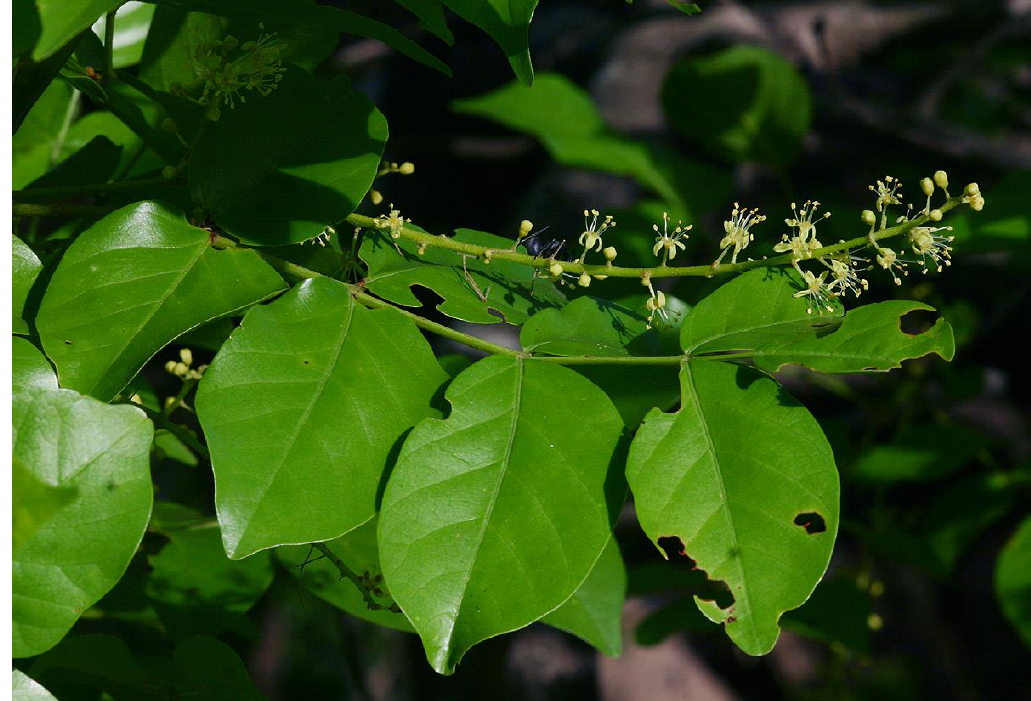
Figure 1. Lannea schweinfurthii : a branch showing leaves and flowers (photo: BT Wursten).